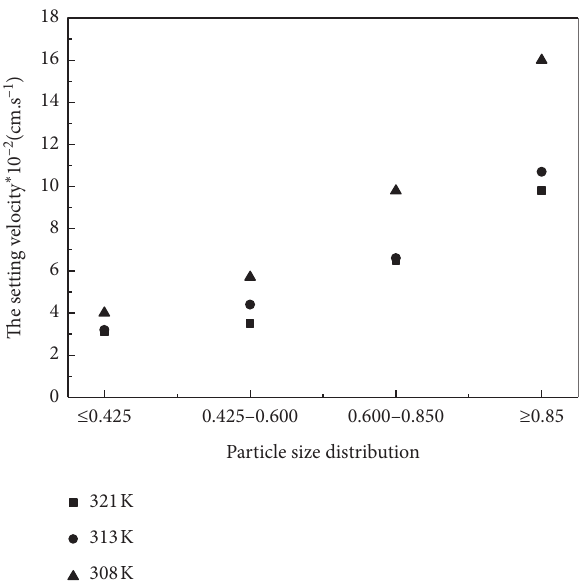
Figure 4: Setting velocity of sodium chloride at different